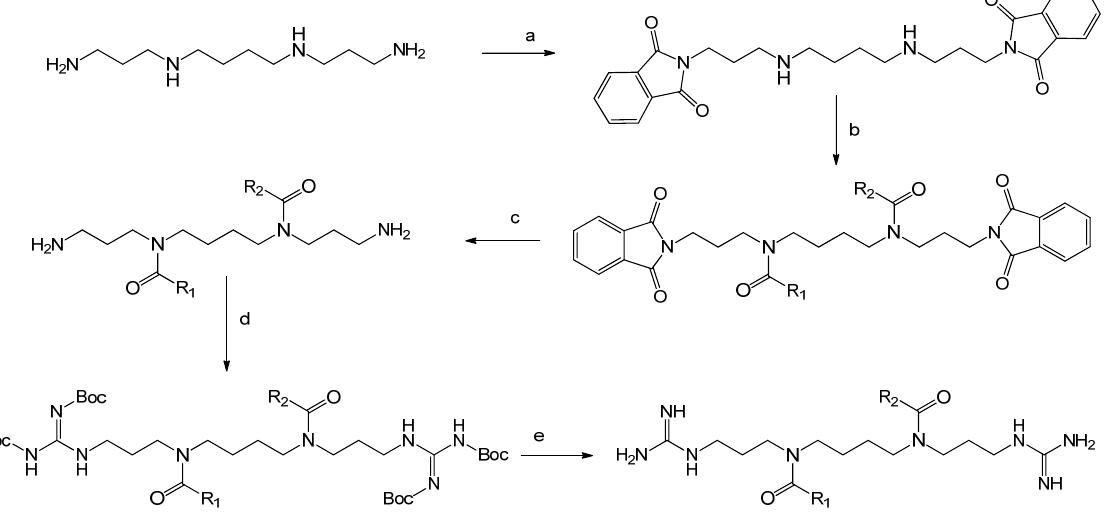
Figure 2. Synthesis of N 1 ,N 12 -diamidino- N 4 ,N 9 -diacylated spermines. a: N - Carbethoxyphthalimide, DCM; b: fatty acid, DCC, TEA; c: hydrazine monohydrate, DCM/THF 1:1 mixture; d: 1,3-di-Boc-2-(trifluoromethylsulfonyl)guanidine, TEA, DCM; e: TFA, DCM.